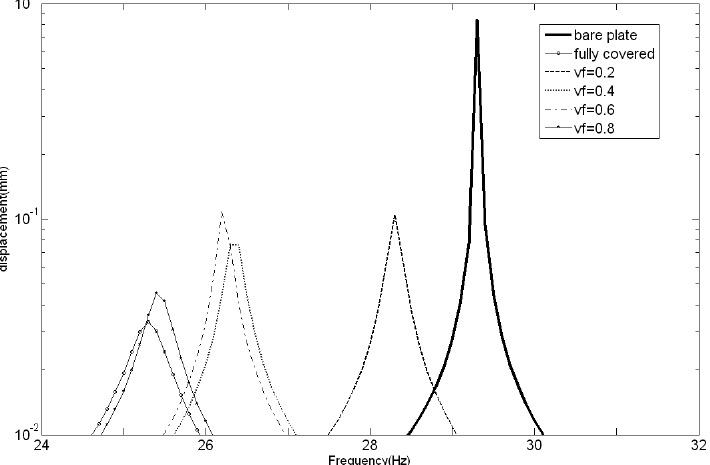
Fig. 15. The second natural frequency.